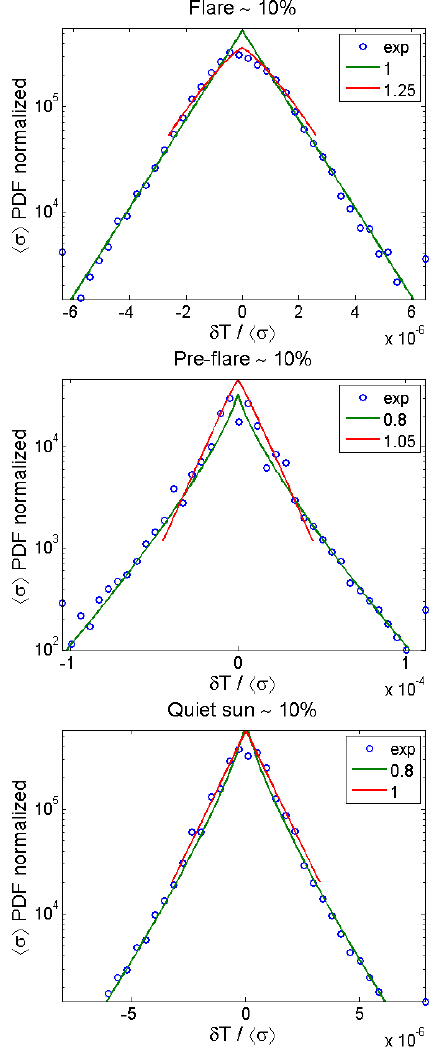
Figure 11. Stretched-exponential fits of the temperature fluctuation PDFs when energy content in small scales is 10%; µ values are given in the legends. (a) Flare ( µ = 1, β = 9.75 × 10 5 and µ = 1.25, β = 1.82 × 10 7 ), (b) pre-flare ( µ = 0.8, β = 9 × 10 3 and µ = 1.05, β = 1.3 × 10 5 ) and (c) quiet Sun ( µ = 0.8, β = 9.1 × 10 4 and µ = 1, β = 10 5